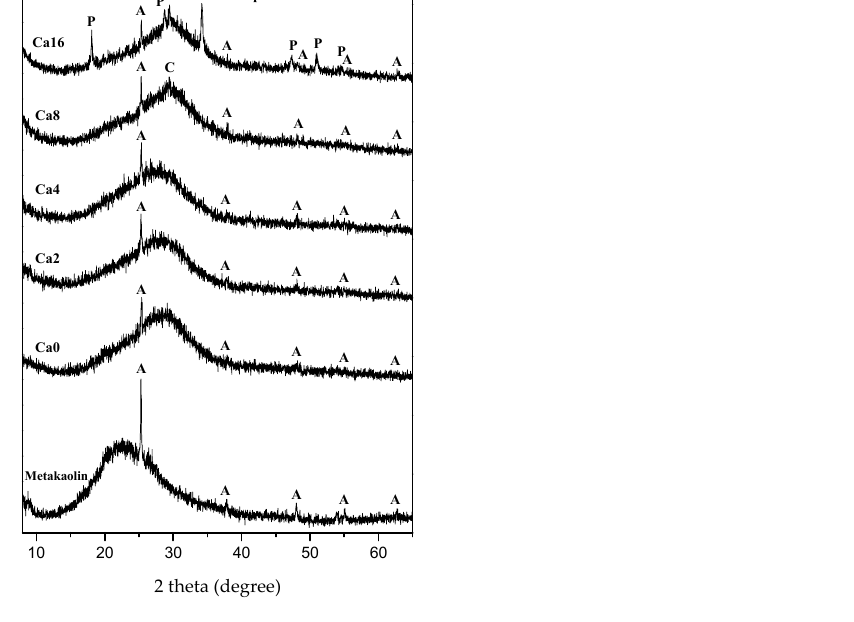
Figure 3. XRD patterns of pure geopolymer and geopolymers containing calcium hydroxide. The newly formed C-S-H gel and unreacted calcium hydroxide were observed in Ca8 and Ca16. The XRD analysis results of Ca16 showed C-S-H gel is rapidly precipitated at the early stage of reaction and some of the calcium hydroxide remains inert in hardened geo- polymers (Figure 4). The Ca16 at the first day of curing was composed of geopolymer presenting an amorphous hump at 2 θ 23°, with C-S-H gel presenting another hump at 2 θ 23°, unreactive metakaolin, and portlandite (Figure 4). At three and seven days of curing, the shape of the amorphous humps of geopolymer and C-S-H gel became more symmet- rical, and the intensity of portlandite peaks decreased (Figure 4). This showed that the dissolution of metakaolin and calcium hydroxide continued with the increase in the cur- ing period (Figure 4). The continued dissolution of calcium hydroxide may supply cal- cium to the C-S-H gel with a low Ca/Si ratio formed at 1 day of curing, so that the C-S-H gel at a longer curing period probably has a higher Ca/Si ratio and the atomic ordering will be increased. Meanwhile, the XRD patterns of three and seven days of curing showed little difference and the intensities of undissolved calcium hydroxide were also similar (Figure 4). Therefore, it can be concluded that C-S-H gel is rapidly precipitated at the early stage of reaction and some of the calcium hydroxide remains inert due to the common ion effect, high pH environment, and exothermic heat of geopolymerization when added as an excessive amount to the geopolymer mixture.